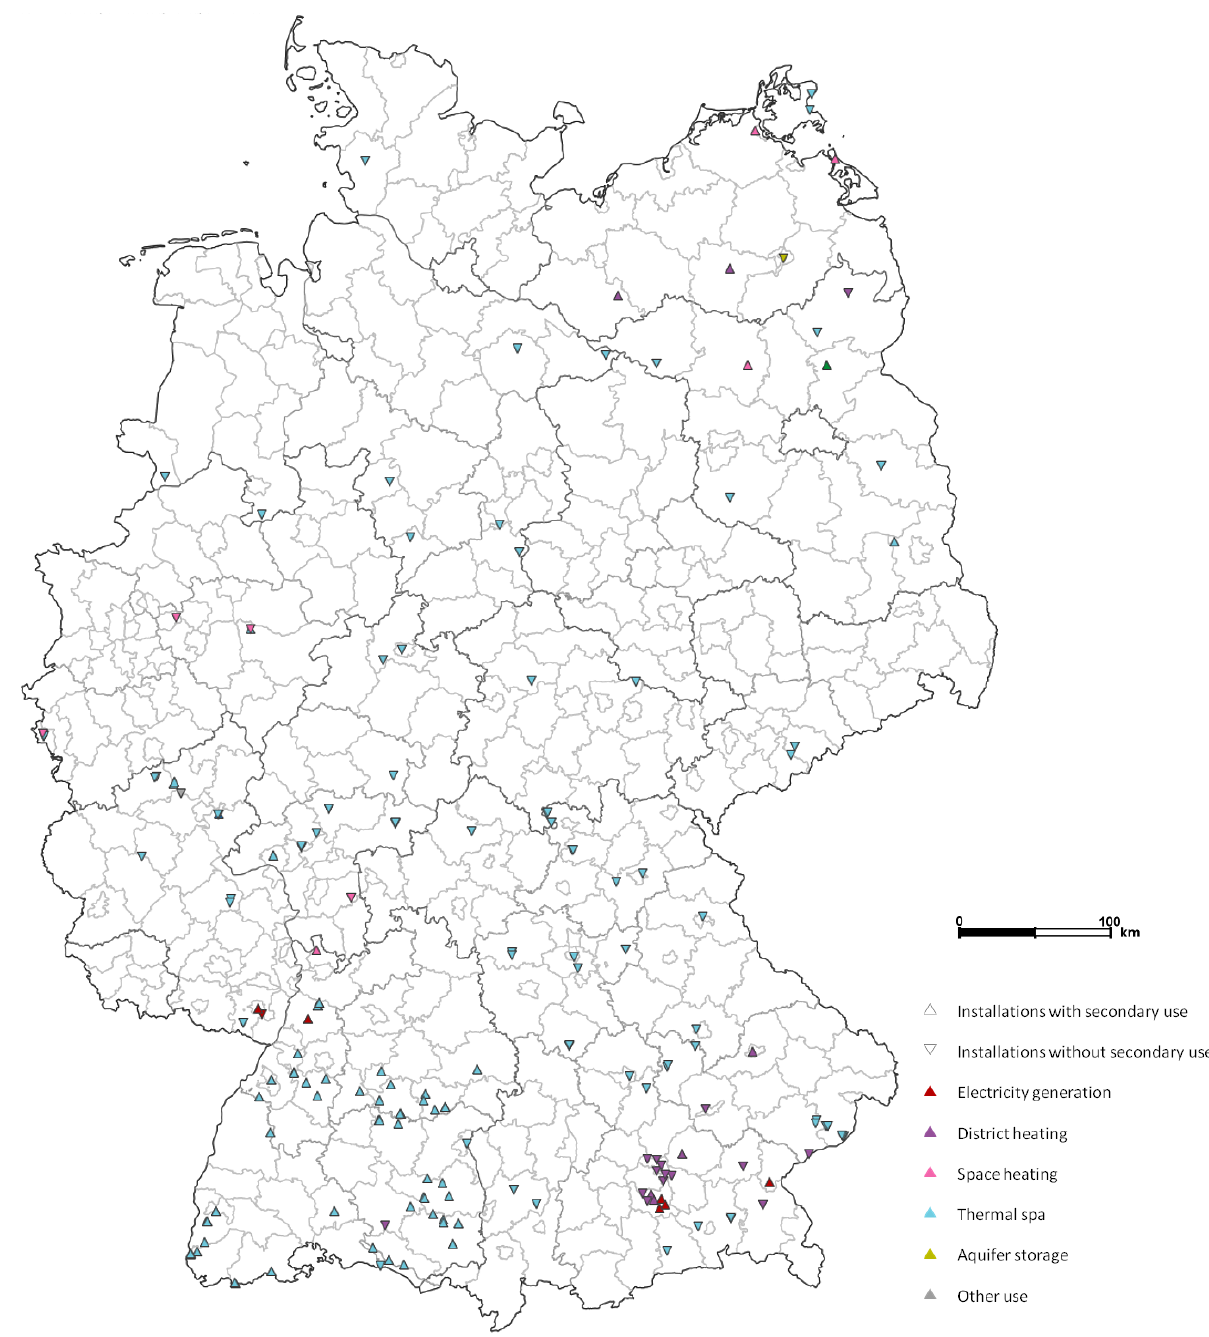
Figure 6. Geothermal installations in